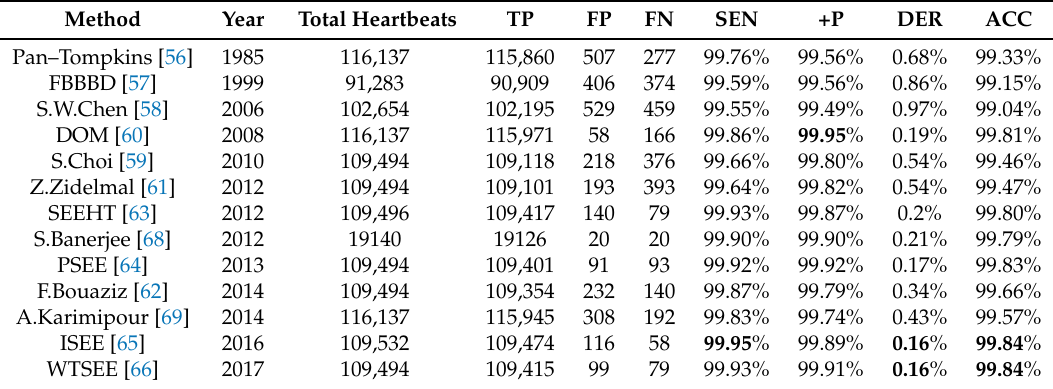
Table 1. The heartbeat detection performance comparison using the MIT-BIH data